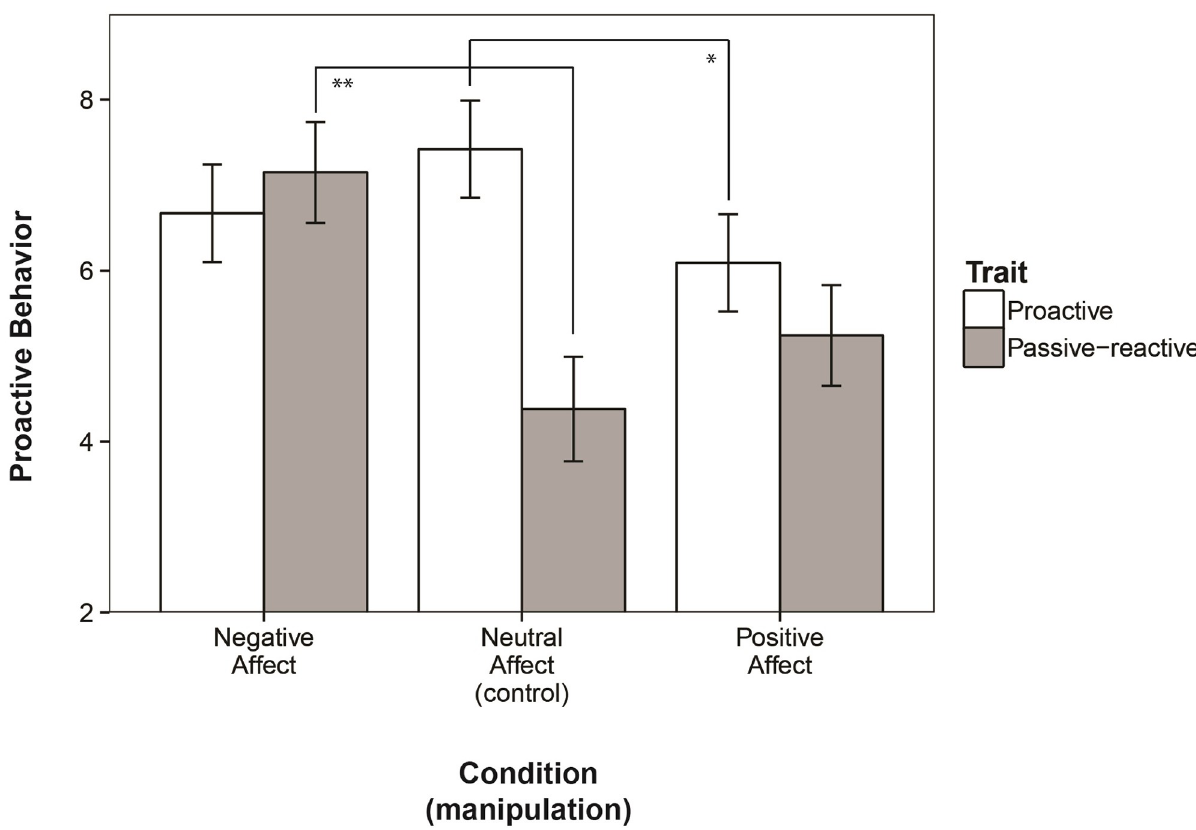
Fig 3. Effects of affect conditions on proactive behavior, moderated by trait-proactivity.